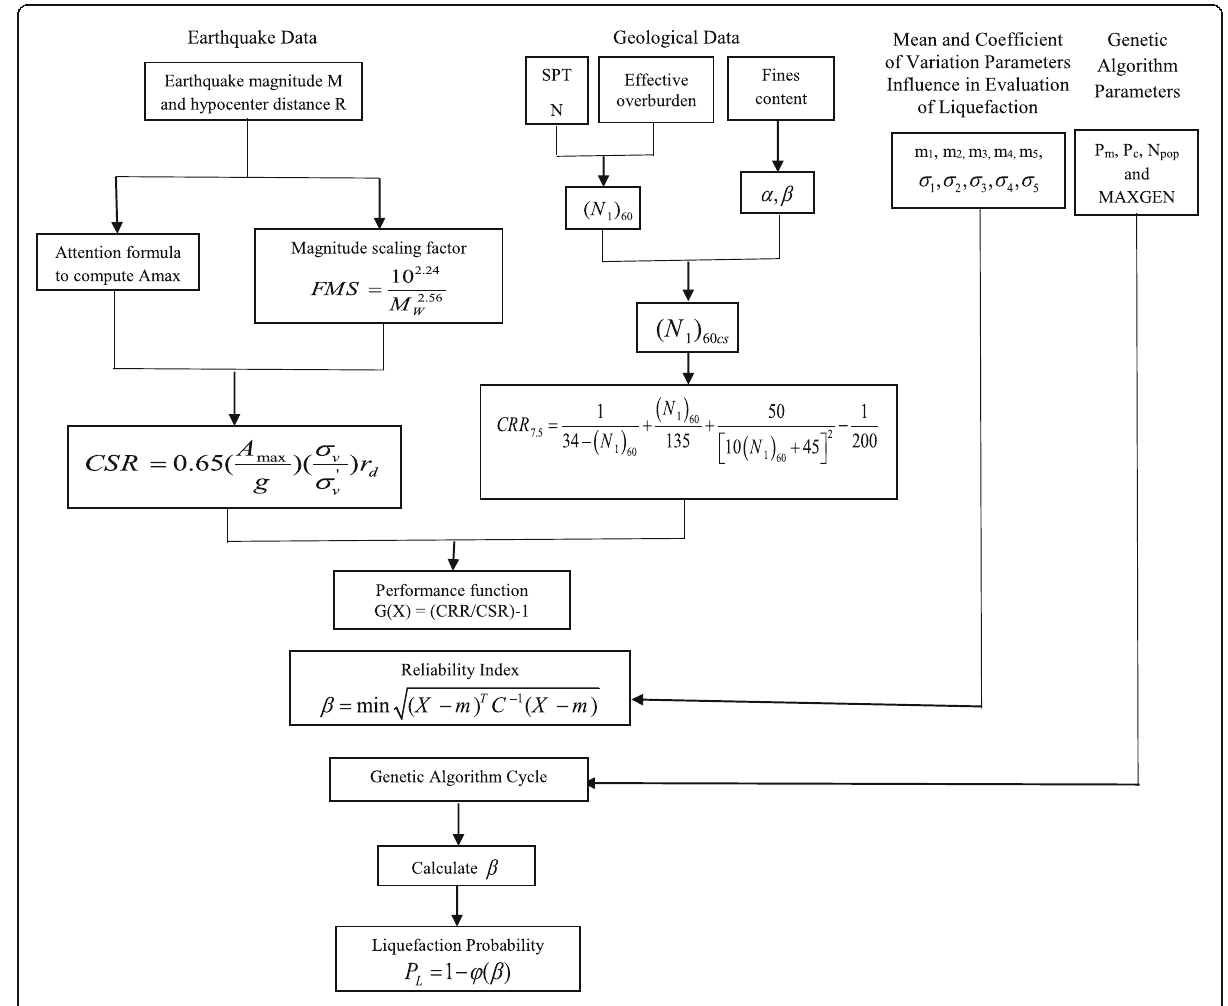
Fig. 4 Flowchart of the proposed concept in the current